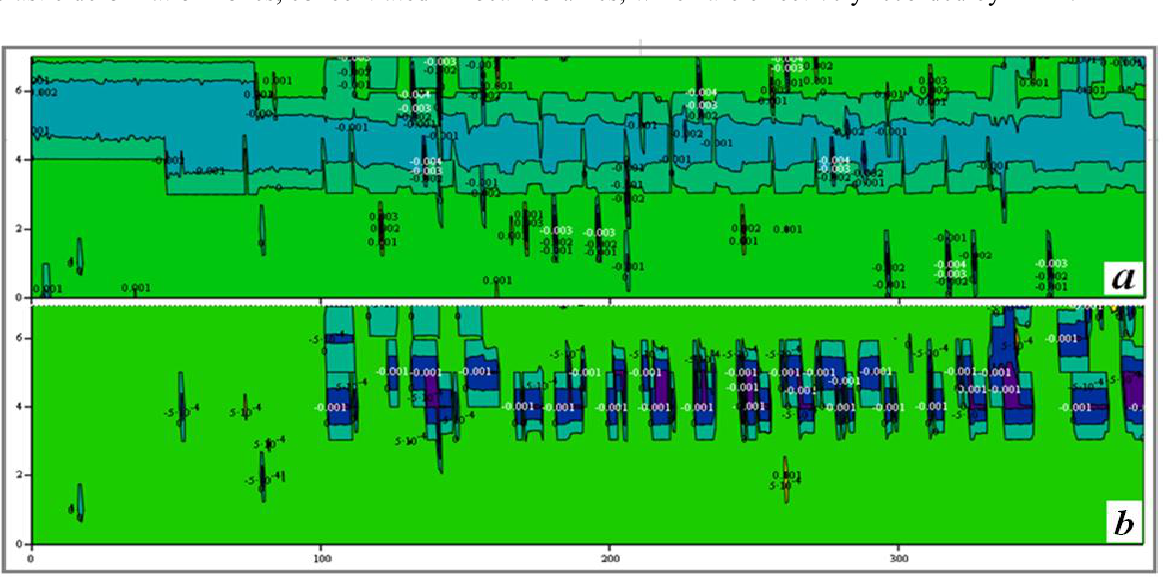
Figure 5. Collector welding joints potentiogram(a) SLS=2.301; (b)